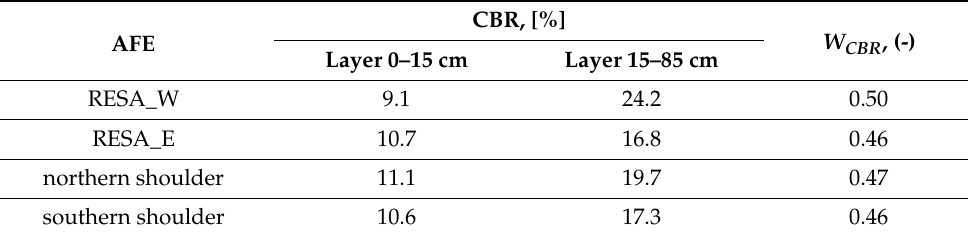
Figure 14. Results of the load capacity of natural airport pavements on the runway end safety areas. Table 7. Average values of the load bearing capacity and the calculated CBR average of the analyzed AFE pavements.